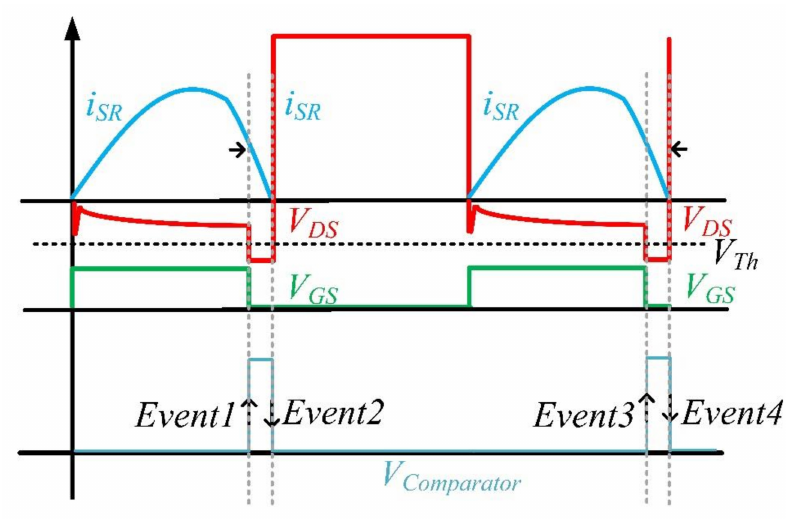
Figure 9. Relationship between V Comparator and V ds .